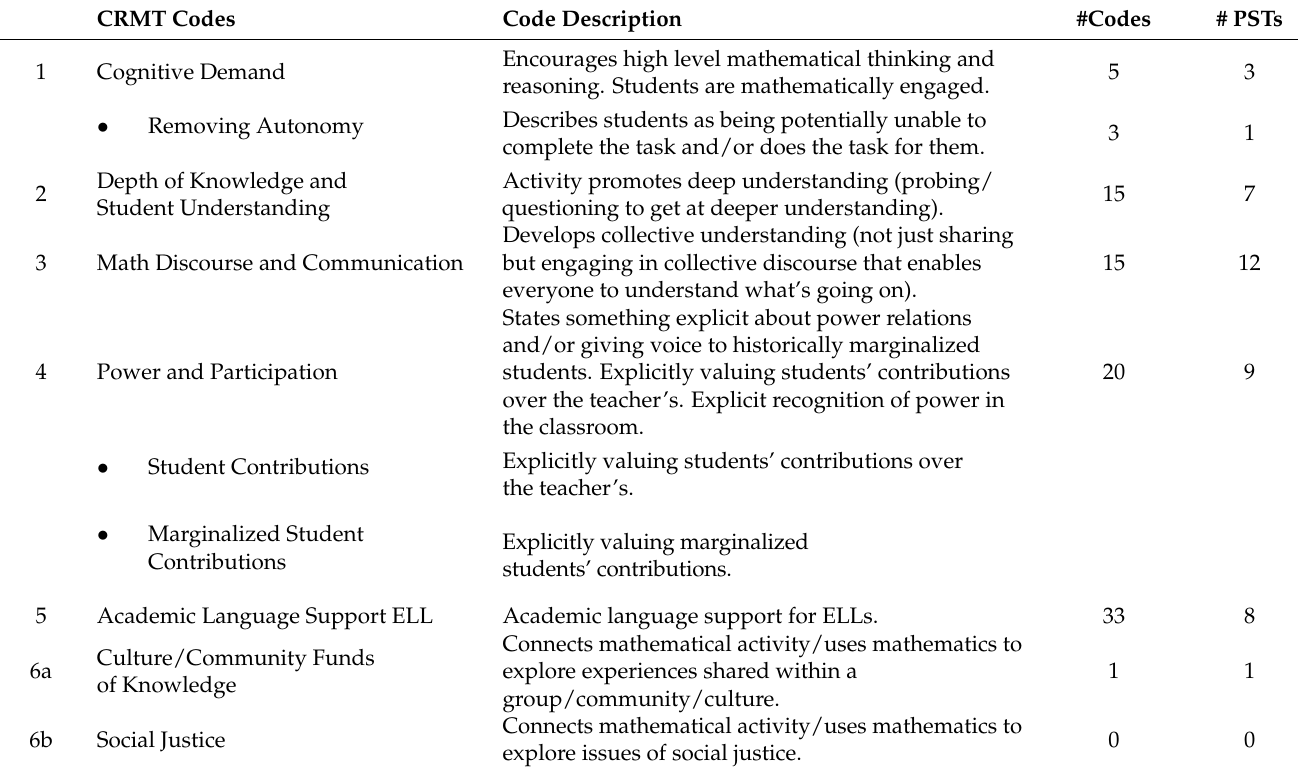
Table A1. Analysis 2